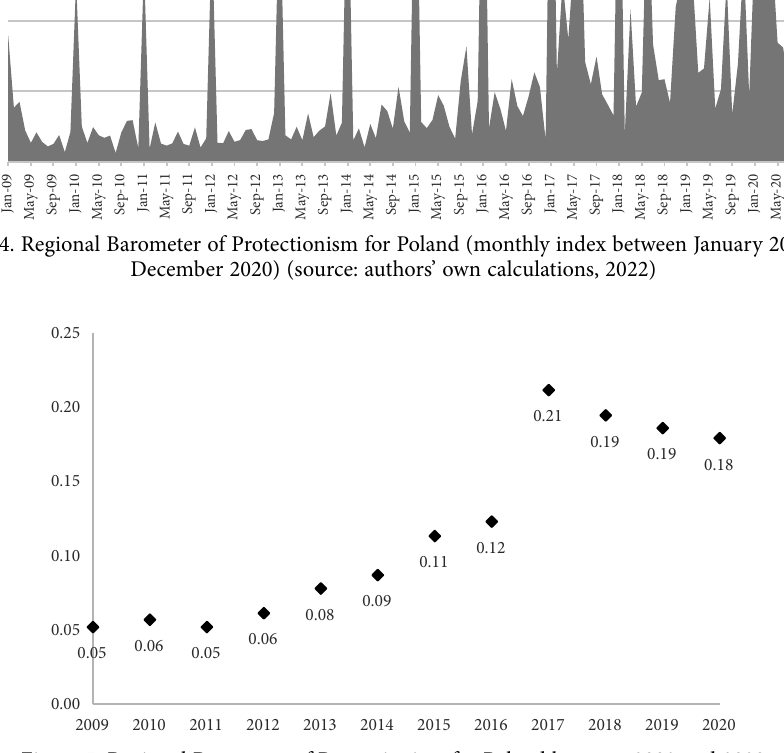
Figure 5. Regional Barometer of Protectionism for Poland between 2009 and 2020 (source: authors’ own calculations, 2022)